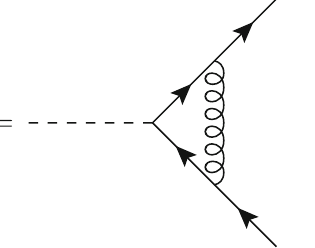
Fig. 1 The one-loop vertex correction to the H → b ¯ b amplitude. The diagram only contains a ‘singular’ gluon field. In dred and fdh there is an additional diagram with the gluon replaced by an (cid:3) -scalar